Question: Based on the figure, does the quantity rise or fall?
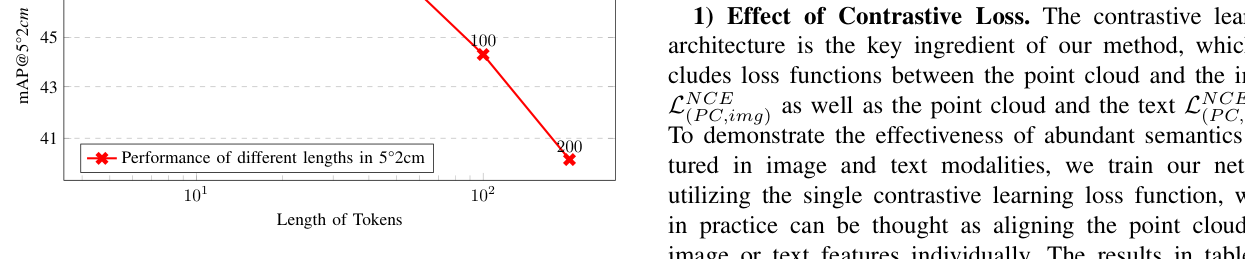
Answer: increasing